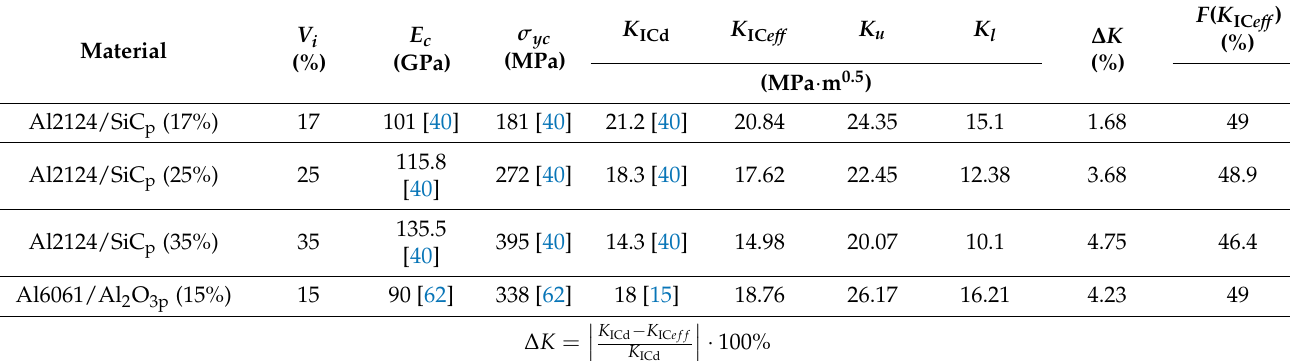
Table 5. Material properties of